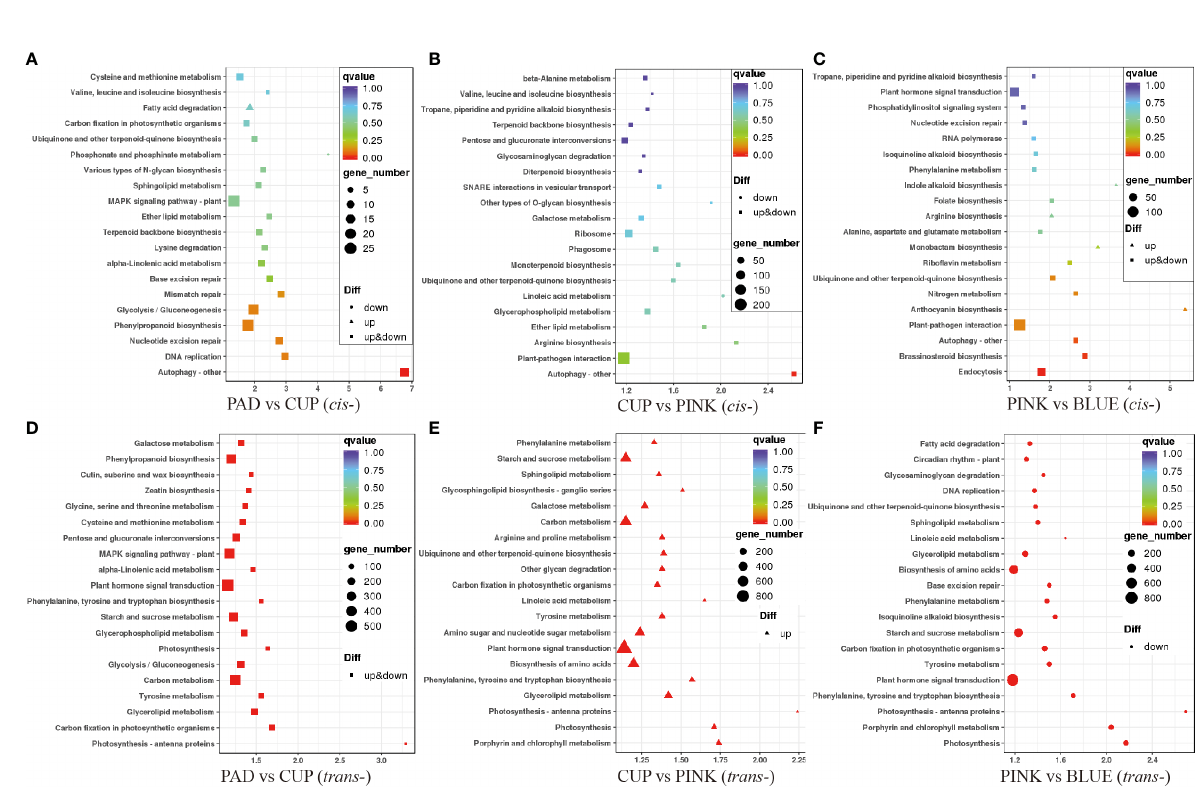
FIGURE 5 Enrichment analysis of target genes of differentially expressed lncRNAs (DE-lncRNAs) in Kyoto Encyclopedia of Genes and Genomes (KEGG) pathways. The ordinate represents the pathway name, and the abscissa represents the enrichment factor. Each dot in the fi gure represented a pathway, and the size indicates the number of genes enriched. The color of the dot represents P-value. Upregulated and downregulated genes are distinguished by triangle and circles, respectively. (A – C) show the cis-target genes of DE-lncRNAs among PAD vs. CUP, CUP vs. PINK and PINK vs. BLUE comparisons, respectively. (D – F) display the trans-target genes of DE-lncRNAs among the above three comparisons,